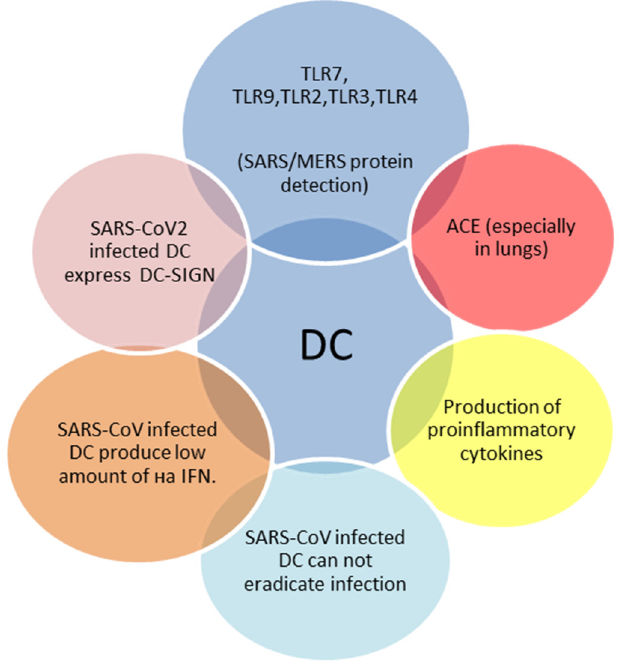
Figure 2. Main features of SARS-CoV-2 infected dendritic cells (DCs) [23,32–34]. Monocytes and macrophages are also part of the first defense line against pathogens.